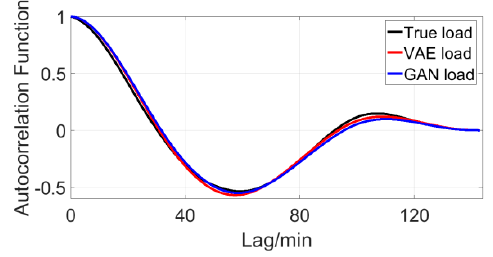
Figure 8. The autocorrelation function of load.